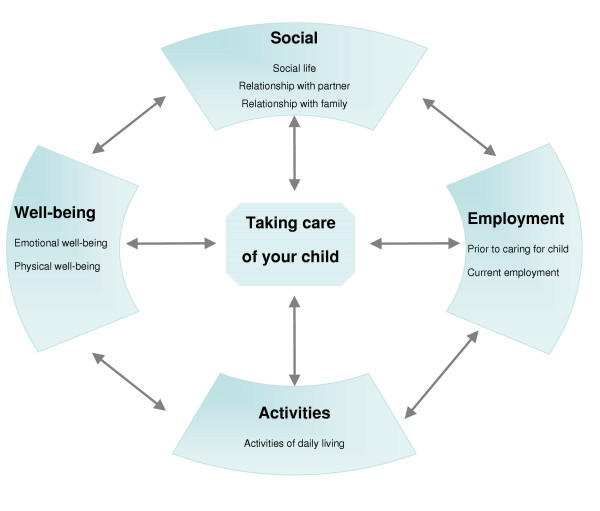
Conceptual Model